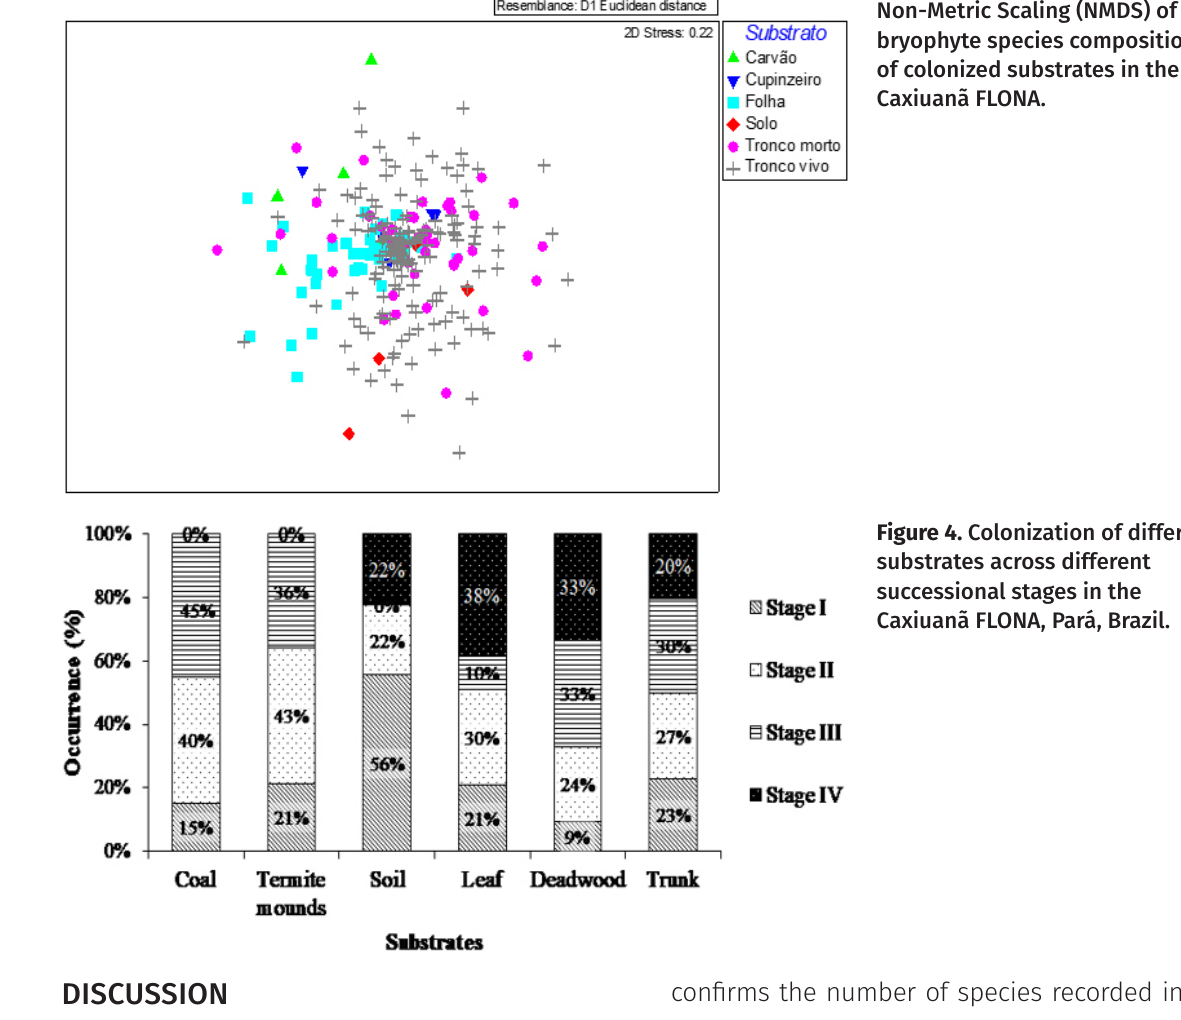
Figure 3. Multidimensional Non-Metric Scaling (NMDS) of bryophyte species composition of colonized substrates in the Caxiuanã